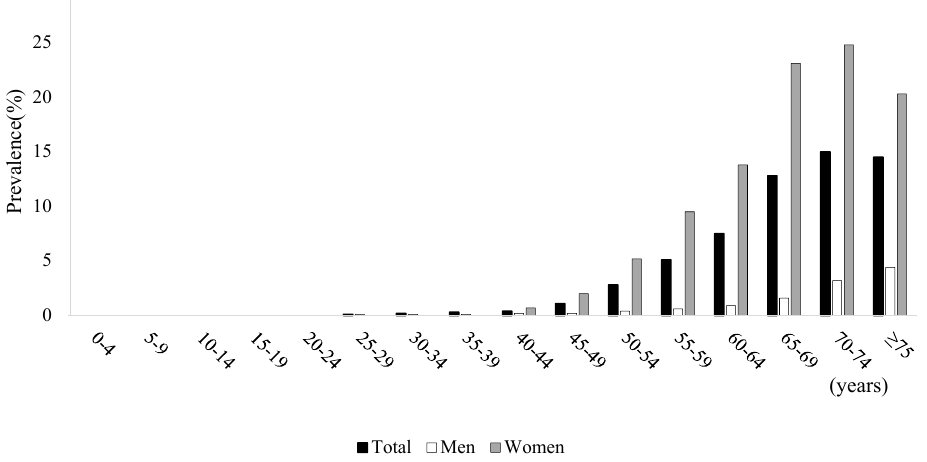
Figure 1. Prevalence based on principal diagnosis and economic burden of osteoporosis by sex and age.